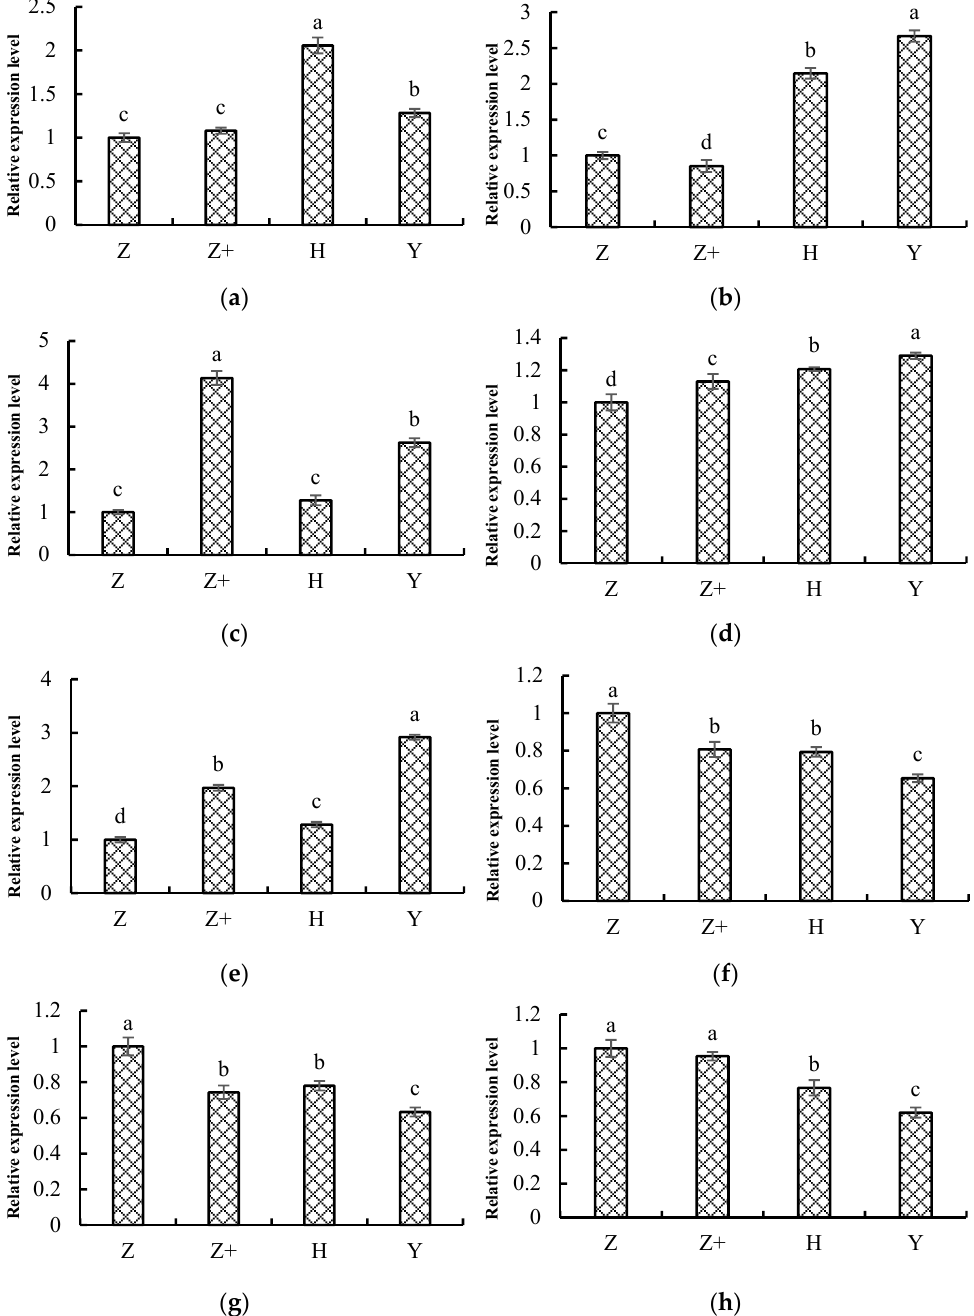
Figure 6. Transcriptome sequencing confirmation by qRT-PCR. The eight genes were randomly selected. Different treatments represent: self-rooted cucumber (Z), self-rooted cucumber with silicon addition (Z+), ‘Huangchenggen No. 2 (cid:48) -grafted cucumber (H) and ‘Yunnan figleaf gourd’-grafted cucumber (Y). Genes were ( a ) ethylene responsive transcription factor ERF054-like; ( b ) WRKY transcription factor 48; ( c ) phenylalanine ammonia-lyase; ( d ) peroxidase 31; ( e ) ABC transporter B family member 2; ( f ) glutathione S-transferase U8; ( g ) chlorophyll a-b binding protein CP26; ( h ) abscisic acid receptor PYL2. Mean value ± standard deviation were represented, and different letters (a, b, c, d) indicate that they were significant differences at 0.05 level according to Duncan